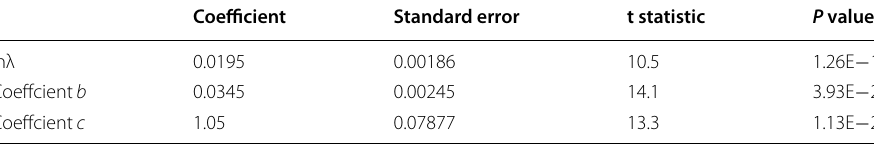
λ 1.020, ROE upper bound =